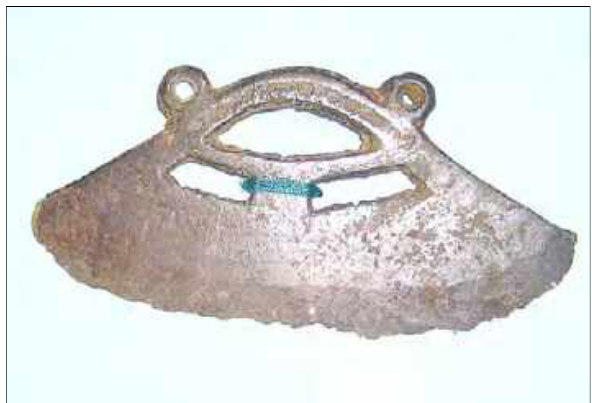
Fig 2.27 Late Bronze Age or Early Iron Age razor from Milnthorpe, Cumbria